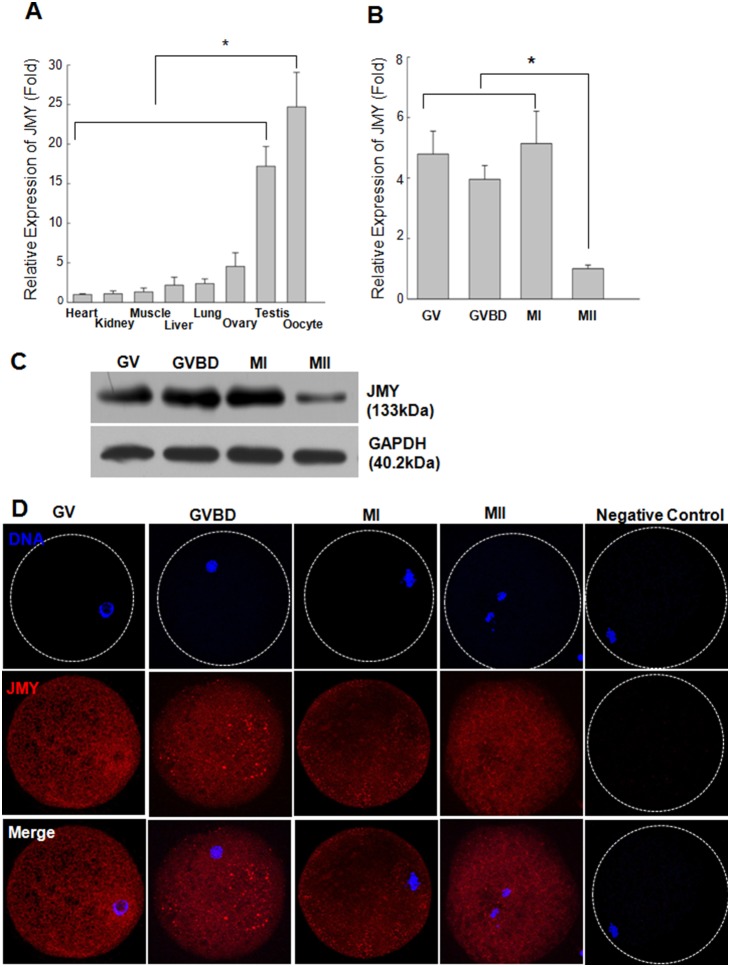
Expression of JMY in different tissues and during porcine oocytes meiotic maturation.A, B: The relative expression of JMY in different tissues (A) and oocytes (B) were measured by quantitative real-time PCR. mRNA levels were normalized to those in heart. Values represent mean ± s.e.m. *p<0.05, n = 3. C: Protein levels of JMY in maturing oocytes measured by western blotting. Two hundreds oocytes were used per lane. D: Subcellular localization of JMY during porcine oocytes meiotic maturation as revealed by immunofluorescence staining. Red: JMY, Blue: chromatin.